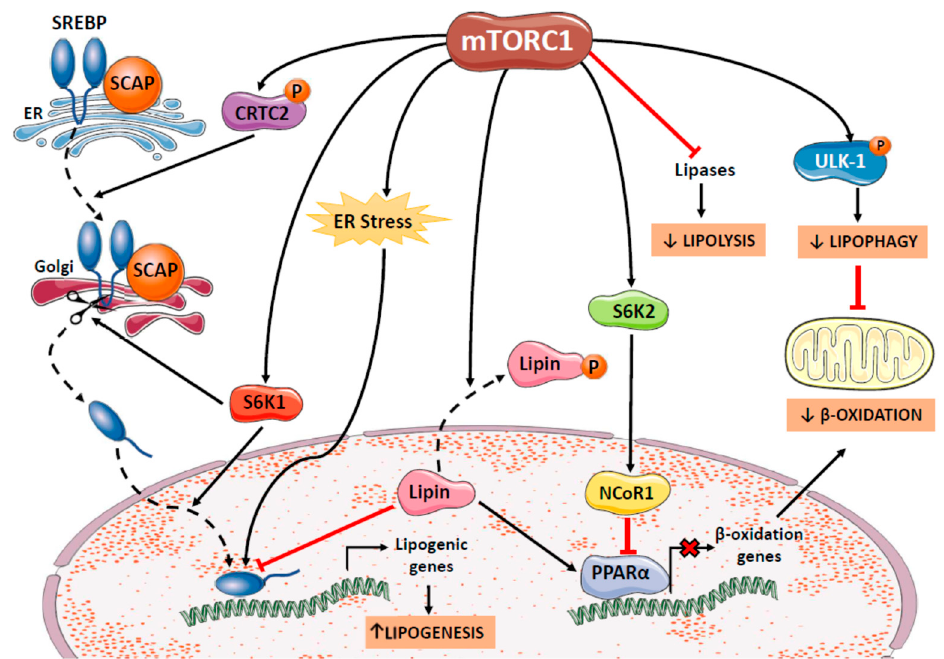
Figure 3. Effects of mTORC1 on lipid metabolism. mTORC1 activates lipogenesis via SREBP1c, partly through S6K1 and also by S6K1-independent mechanisms, such as the phosphorylation